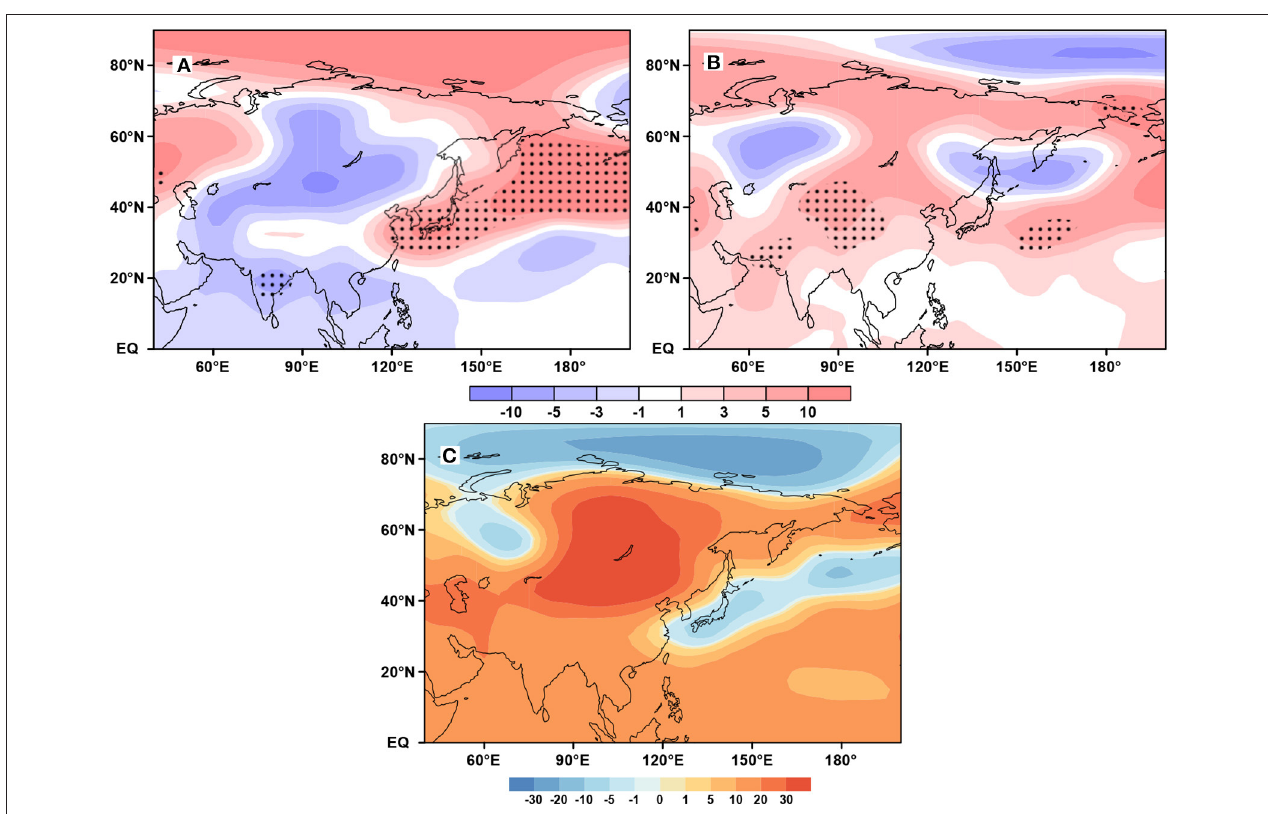
FIGURE 8 | As in Figure 7 except for the results of KCS